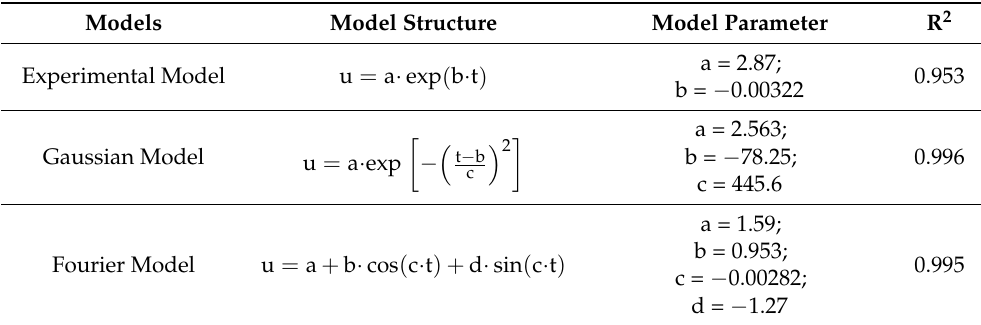
Table 2. Fitting results of drying curve data in